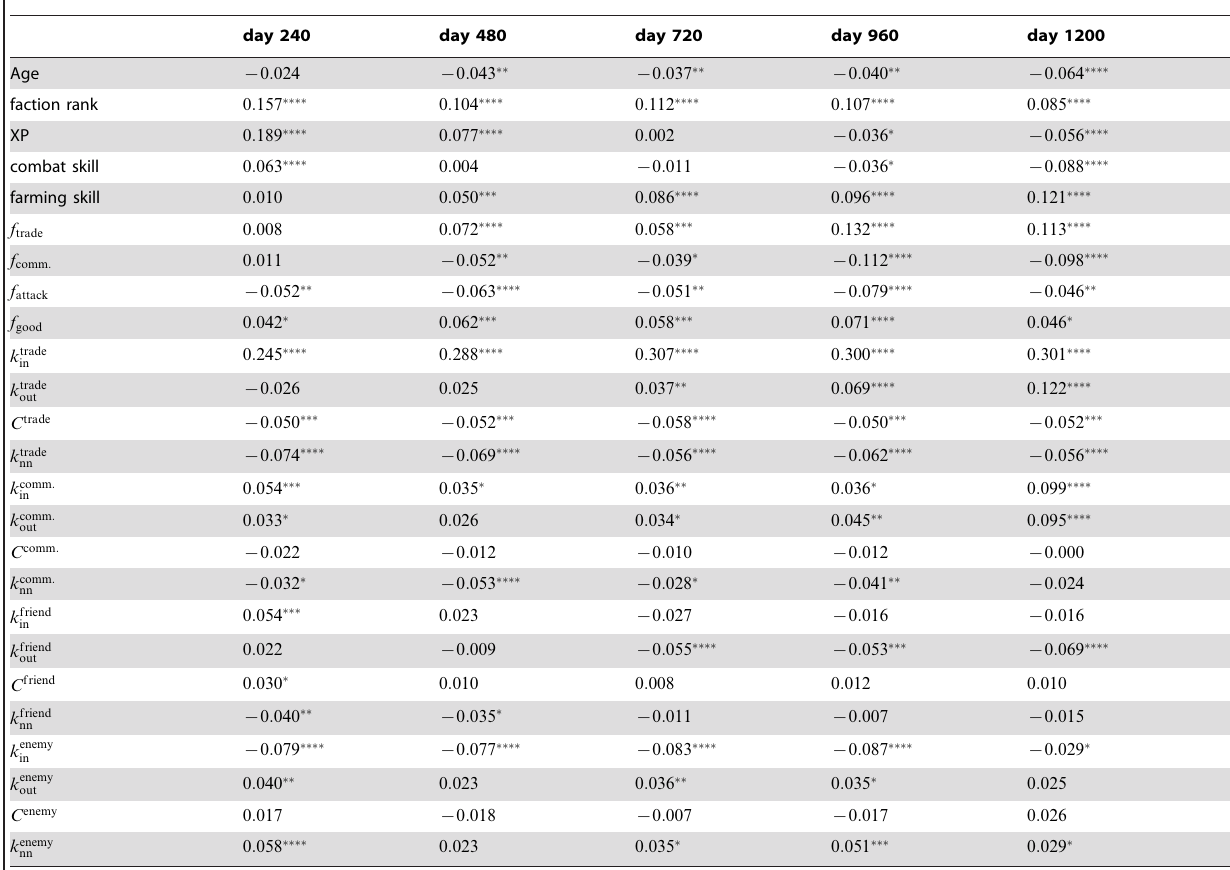
Table 2. Partial correlation coefficients for wealth controlling for total activity.